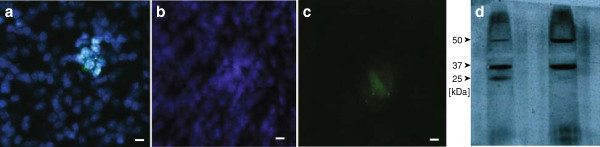
YFP is expressed in the epithelial cells of the terminal airways. YFP expression patterns observed using confocal microscopy of mouse lung parenchyma cryosections 24 hours after (a, b and c) dosage of 75 μg with post-nebulized pVR1020–YFP in 0.9% NaCl aqueous solution showing (a) YFP expression in a cluster of epithelial cells where lung cell nuclei stained with DAPI dilactate appear blue while cells expressing YFP appear green (scale bar =5 μm); (b) another view of a part of the YFP-expressing cell region shows the YFP distribution in the cells with appropriate filtering to (b) show only the nuclei and (c) YFP (scale bar =5 μm). (d) Western blot of the supernatant obtained from homogenized mice lungs harvested (left lane) 24 hours post-transfection with 300 μg pVR1020–YFP plasmid that was SAW nebulized at 30 MHz and instilled, compared to (right lane) the supernatant from untreated mice lungs. The YFP protein appears clearly at 27 kDa. The additional protein bands present at 50 and 37 kDa for both groups are due to the polyclonal nature of the rabbit anti-YFP antisera used as the probe where cross-reactivity was induced across other serum proteins.